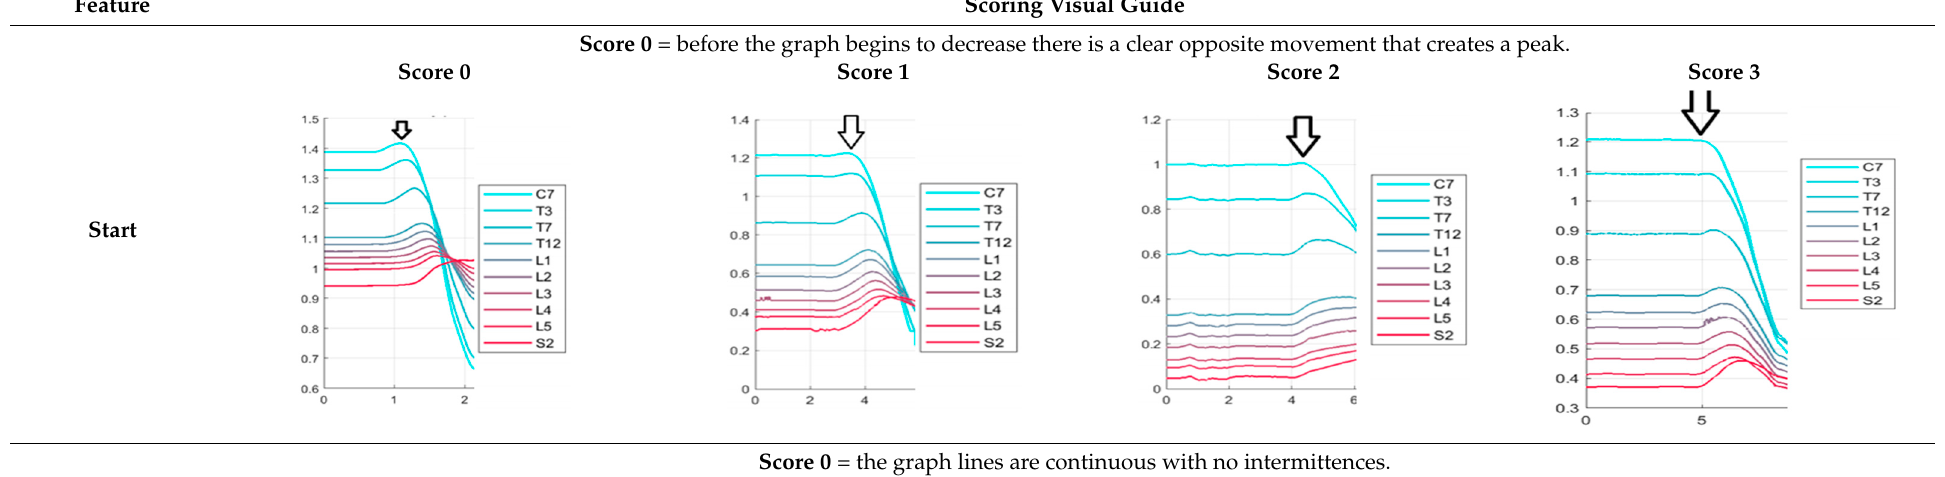
Table A1. Flexion and return features.